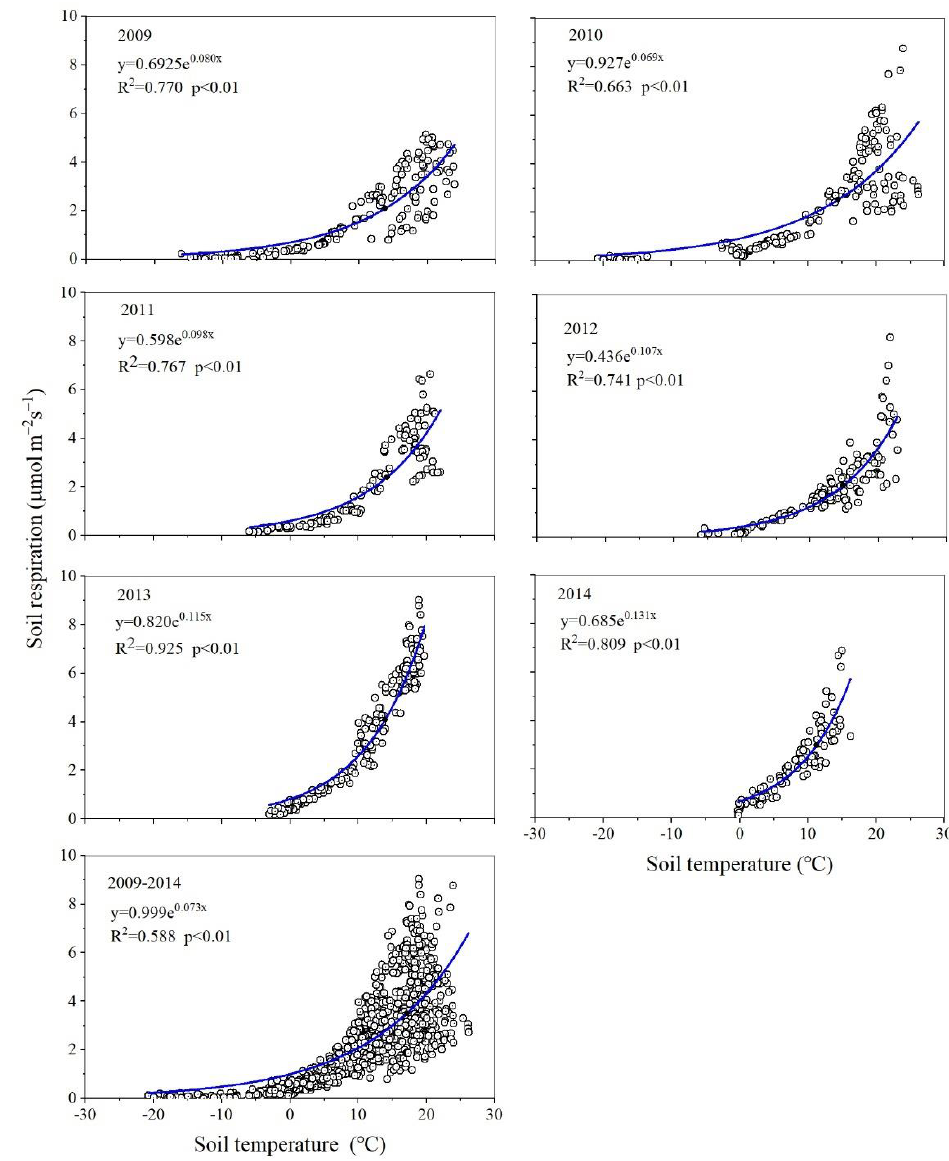
Figure 2. Relationship between soil respiration and soil temperature at 10 cm depth during 2009 – 2014.